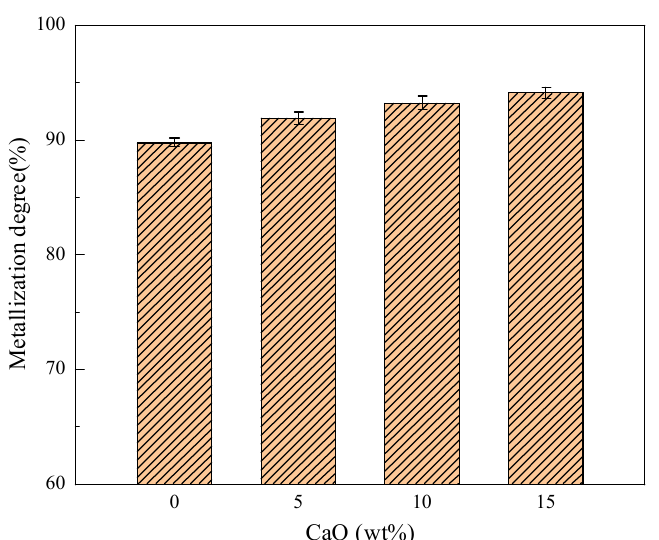
Figure 5. Effect of the added amount of CaO on the metallization degree of the reduced samples.